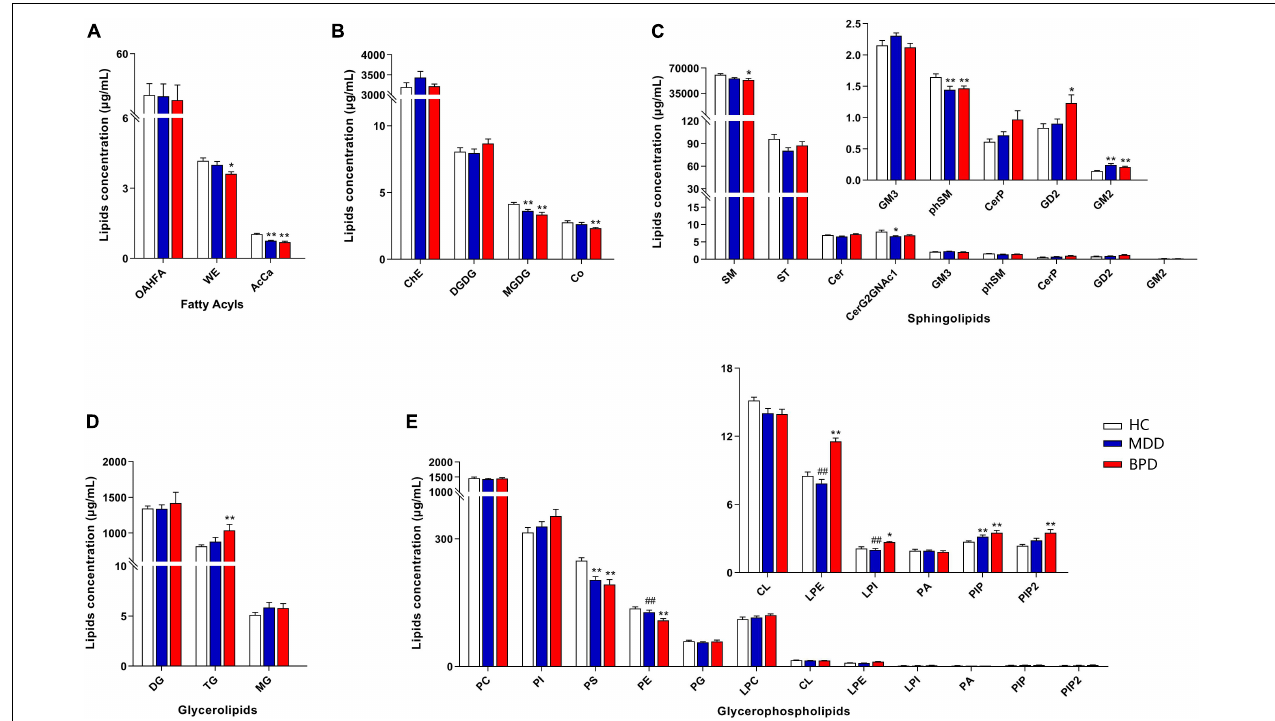
FIGURE 1 | Differential concentration of lipid class among major depressive disorder (MDD), bipolar depression (BPD), and healthy controls (HC). (A) Fatty acyls, (B) ChE, Co, DGDG, and MGDG, (C) sphingolipids, (D) glycerolipids, (E) glycerophospholipids. HC, healthy controls; MDD, major depressive disorder; BPD, bipolar depression; OAHFA, (O-acyl)-1-hydroxy fatty acid; WE, wax esters; AcCa, acylcarnitine; ChE, cholesterol ester; Co, coenzyme; DGDG, digalactosyldiacylglycerol; MGDG, monogalactosyldiacylglycerol; SM, sphingomyelin; ST, sulfatide; Cer, ceramides; CerP, ceramides phosphate; phSM, phytosphingomyelin; DG, diglyceride; TG, triglyceride; MG, monoglyceride; PC, phosphatidylcholine; PI, phosphatidylinositol; PS, phosphatidylserine; PE, phosphatidylethanolamine; PG, phosphatidylglycerol; CL, cardiolipin; LPC, lysophosphatidylcholine; LPE, lysophosphatidylethanolamine; LPI, lysophosphatidylinositol; PA, phosphatidic acid; PIP, phosphatidylinositol; PIP2, phosphatidylinositol 4,5-bisphosphate. * P < 0.05 vs. HC; ** P < 0.01 vs. HC, ## P < 0.01 vs.